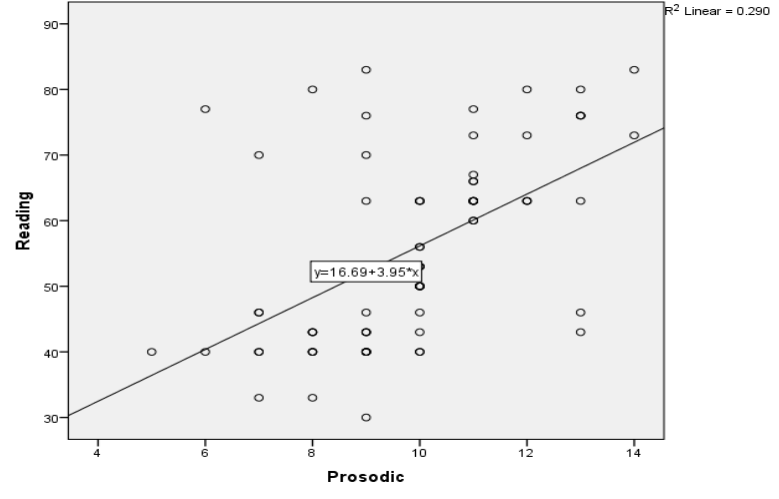
Figure 2. The regression equation